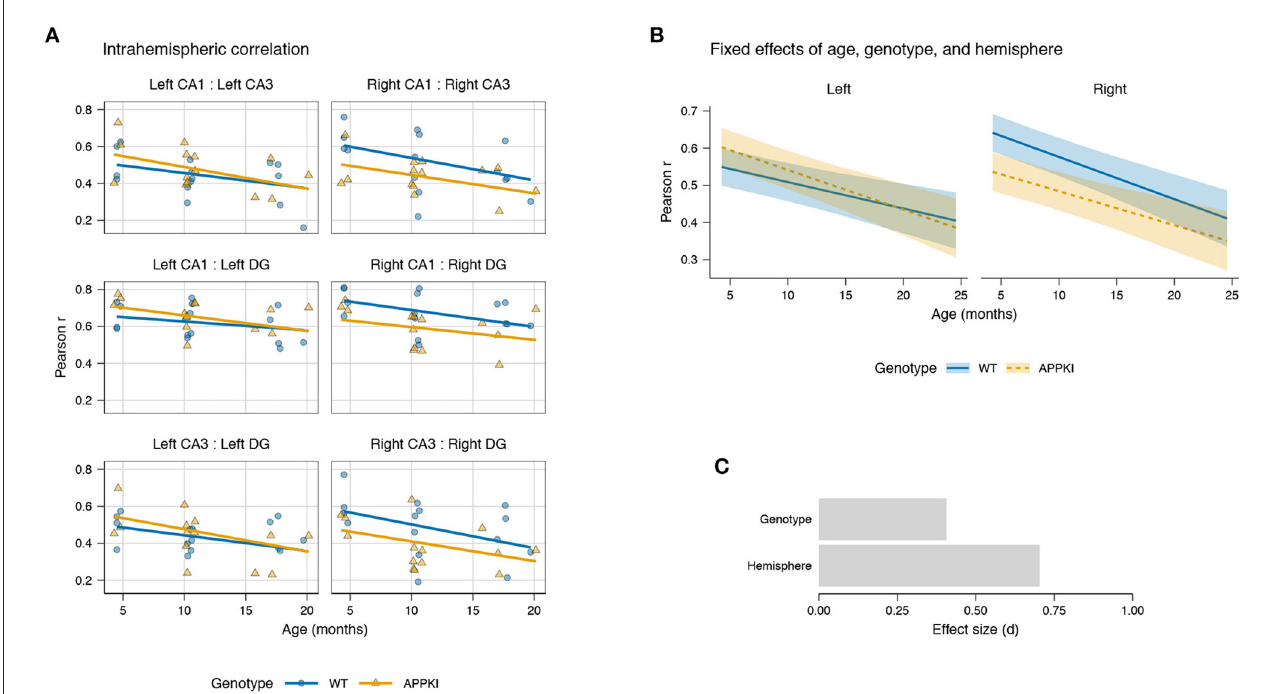
FIGURE3 Hippocampal intrahemispheric correlation by age and genotype. (A) Linear mixed model fit for intrahemispheric correlation between subregions for CA1, CA3, and DG in each hemisphere. Points represent mean intrahemispheric FC for each subject. Lines represent model fit. (B) Fixed effects of age, genotype, and hemisphere on correlation. Lines represent model fit. Shaded areas represent standard error. Blue: wild-type; orange: App NL-G-F/NL-G-F . (C) Effect sizes of genotype and hemisphere on correlation.